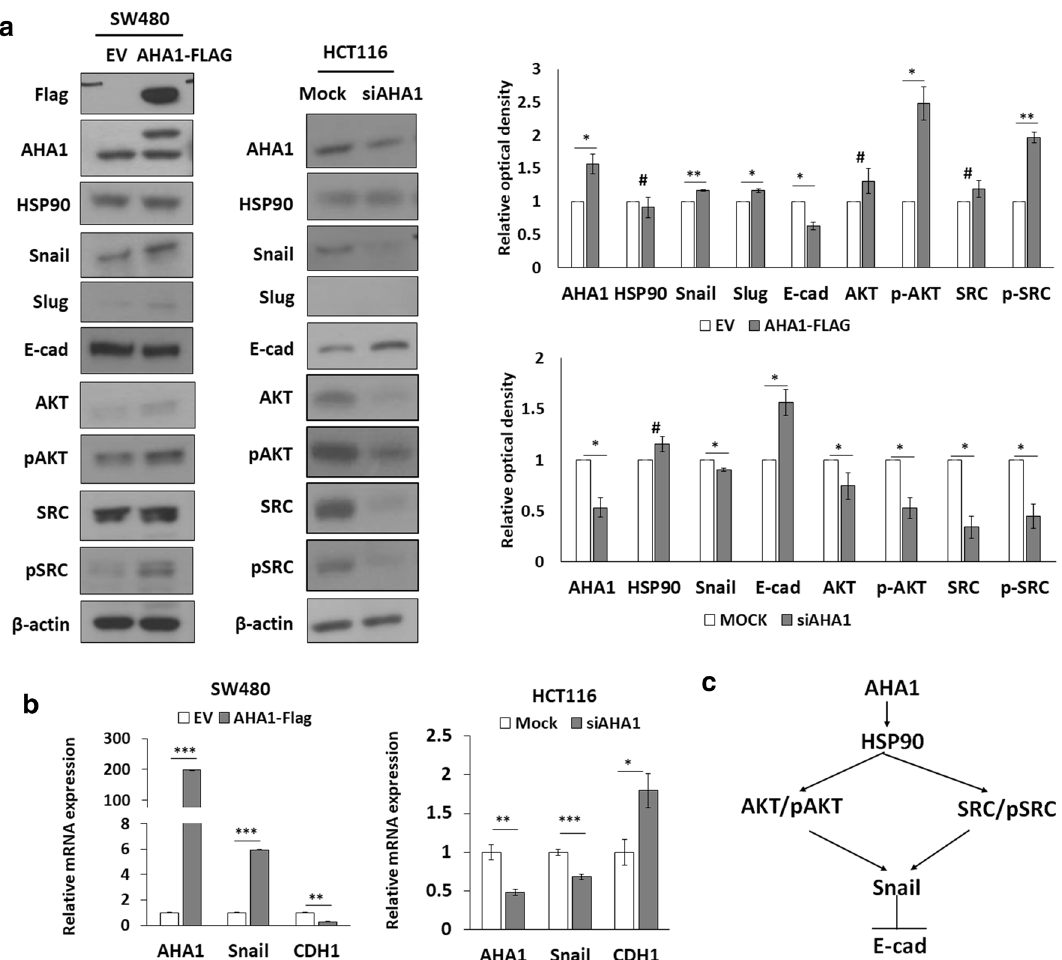
Figure 4. AHA1 regulates EMT signaling through Snail, E-cadherin, pAKT, and pSRC. ( a , b ) Overexpression of AHA1 by transfection of AHA1 -Flag for 24 h in SW480 induced a decrease in the levels of E-cadherin, and an increase in the levels of Snail, pAkt, and pSrc expression. Downregulation of AHA1 by transfection of si AHA1 for 48 h in HCT116 induced an increase in the levels of E-cadherin, and a decrease in the levels of Snail, pAkt, and pSrc expression. Expression of proteins was determined with western blotting ( a ), and that of mRNA was determined using qRT-PCR ( b ). The densitometry quantification of the western blot determined using Image J software (Ver. 1/52n, NIH). *p < 0.05, **p < 0.01, ***p < 0.001, # p ≥ 0.05 compared with control. ( c ) Schematic diagram of AHA1 regulated